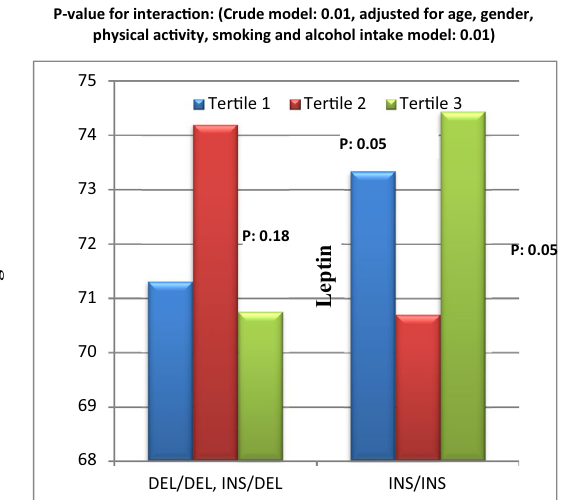
Figure 1. Interaction between Apo B INS/DEL SNP and DQI-I on serum prostaglandin F2α